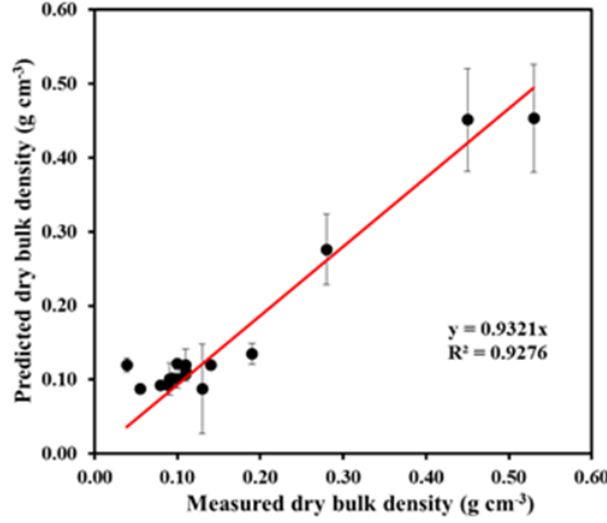
Figure A2. Regression of predicted dry bulk density on measured dry bulk density for a set of Irish peats. Standard error of observations = 0.0320, P < 0.001. Vertical bars show the range in predicted bulk density based on the range in measured moisture